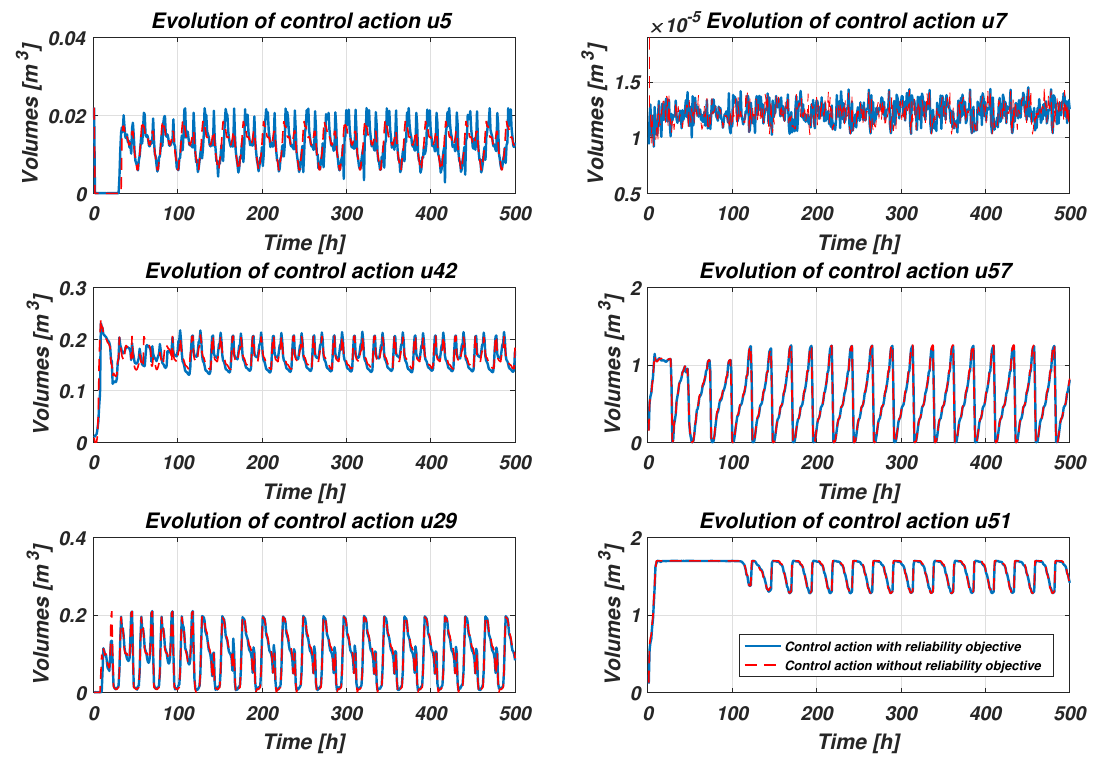
Figure 10. Evaluation of the control actions